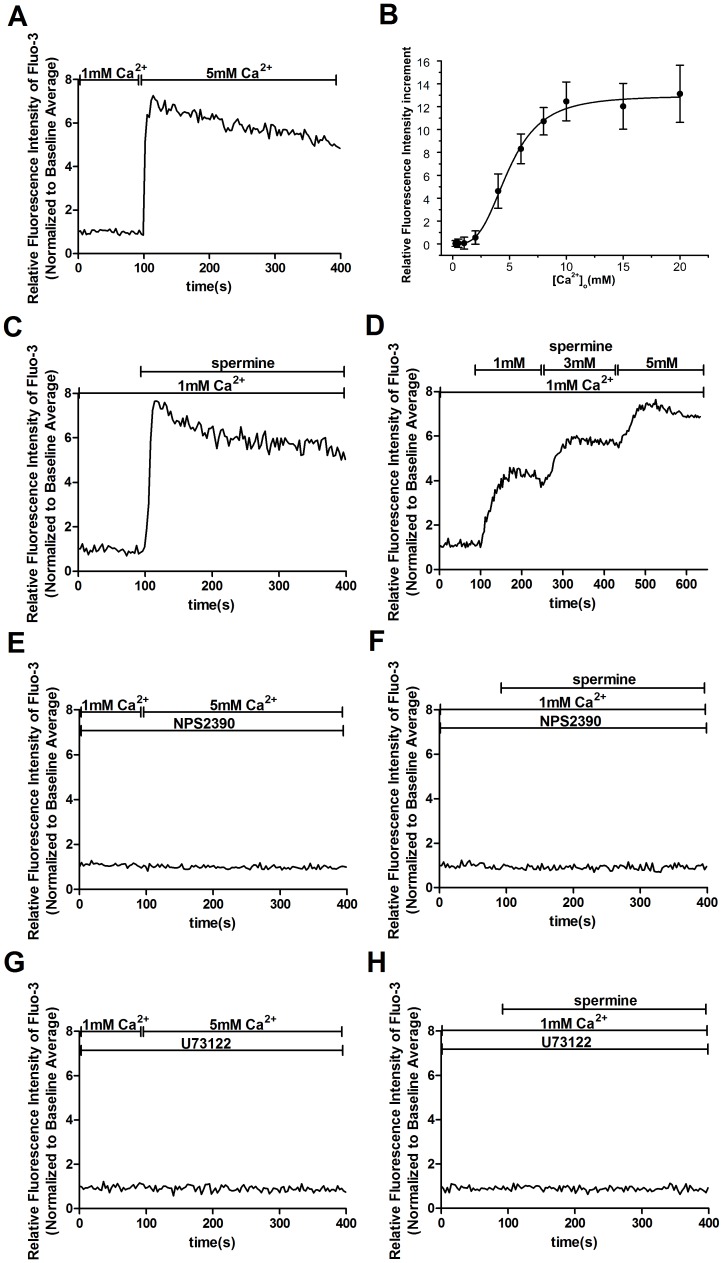
Activation of CaSR induces an increase in [Ca2+]i in human MCs.[Ca2+]i dynamics were monitored by Fura-3 fluorescence methods with a laserconfocal scanning microscope. Representative traces are shown in A and C-H. (A) An increase in [Ca2+]o from 1 to 5 mM evokes a rapid peak and a subsequent sustained elevated level of [Ca2+]i. (B) Summary of data showing a concentration-dependent relationship for the effect of [Ca2+]o stimulation or peak [Ca2+]i responses. Human MCs were stimulated with different concentrations of [Ca2+]o (0.5–20 mM). Data are shown as the means ± SEs of 40–50 cells. (C) In the presence of extracellular Ca2+ (1 mM), addition of 3 mM spermine evokes a rapid peak of [Ca2+]i and a subsequent sustained increase in [Ca2+]i. (D) Dose-dependence of the spermine-induced increase in [Ca2+]i. Cells were stimulated by different concentrations of spermine (1–5 mM) in medium containing 1 mM Ca2+. (E, F) Pretreatment with 10 µM NPS2390 for 20 min inhibits the 5 mM [Ca2+]o(E)- or 3 mM spermine(F)-induced [Ca2+]i increase (p<0.01 vs. NPS2390(-), n = 6), respectively. (G, H) Treatment with 5 mM [Ca2+]o(G) or 3 mM spermine(H) induced an increase in [Ca2+]i, and this increase is inhibited by pretreatment with 30 µM U73122 for 20 min (p<0.01 vs. U73122(-), n = 6), respectively. The results were from at least three independent experiments, and each experiment measured 20 to 40 cells.